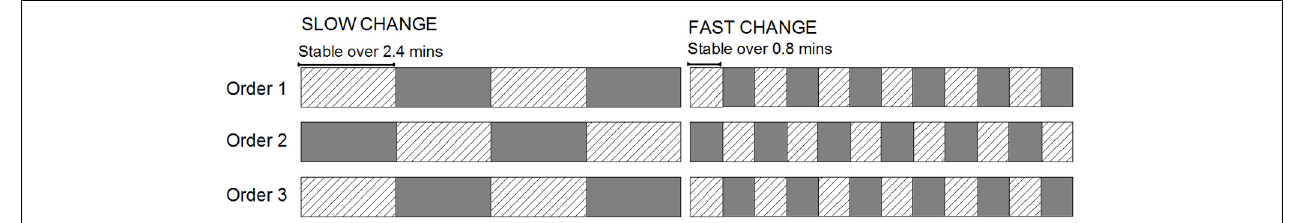
FIGURE 1 | A diagrammatic representation of the structure of conditions presented within the sound sequence. The cross-hatched rectangles represent one deviant block type and the grayed rectangles, the other. For half the participants (Low-High-Low group), the grayed rectangles were “high-pitch deviant” blocks where the 1000Hz tone